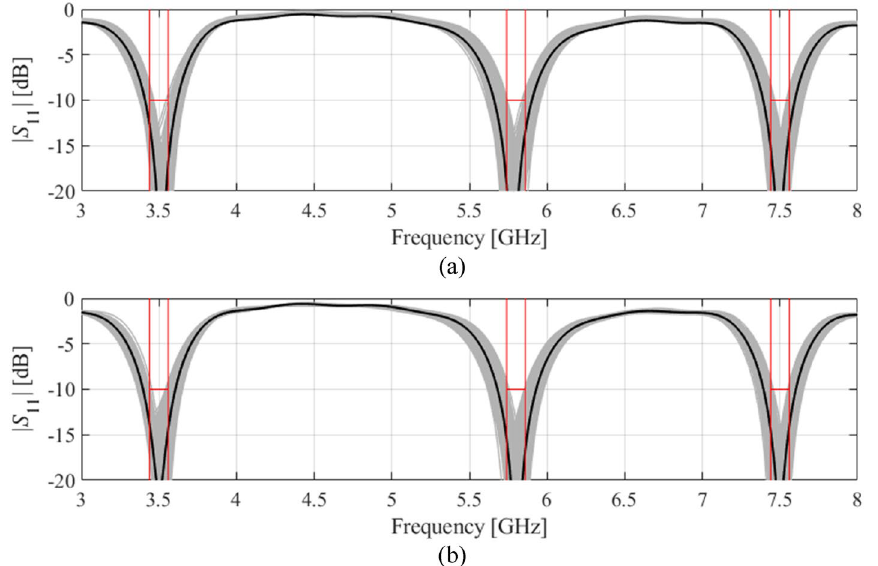
Figure 7. Visualization of EM-driven Monte Carlo simulation of Antenna IV using 500 samples. Gray plots represent random observables, whereas the black plot is the antenna response at the center design (nominal for ( a ) and yield-optimized for ( b )). Target operating bandwidths and reflection level has been marked using vertical and horizonal lines, respectively: ( a ) nominal design, (b) robust